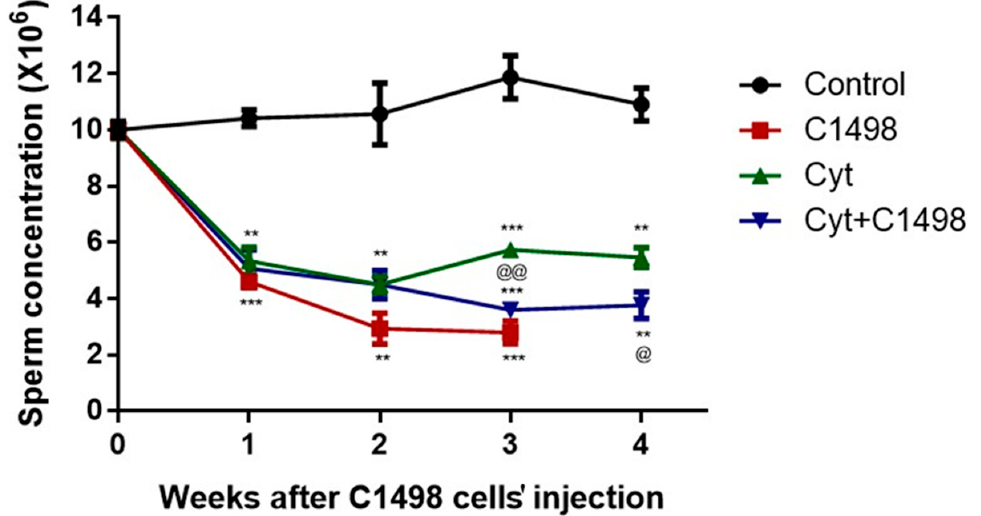
Figure 2. Effect of AML cells, cytarabine, and the combination of both on sperm concentration: Mice were treated as described in Figure 1. Sperm were extracted from the epididymis 1–4 weeks post-treatment. Sperm concentration was evaluated using a Makler counting chamber and determined according to WHO criteria. The results are representative of three independent experiments with 8–10 mice in each group. * Significant compared to control. @ Significant for Cyt + C1498 compared to Cyt. *, @ p < 0.05; **, @@ p < 0.01; ***, @@@ p <